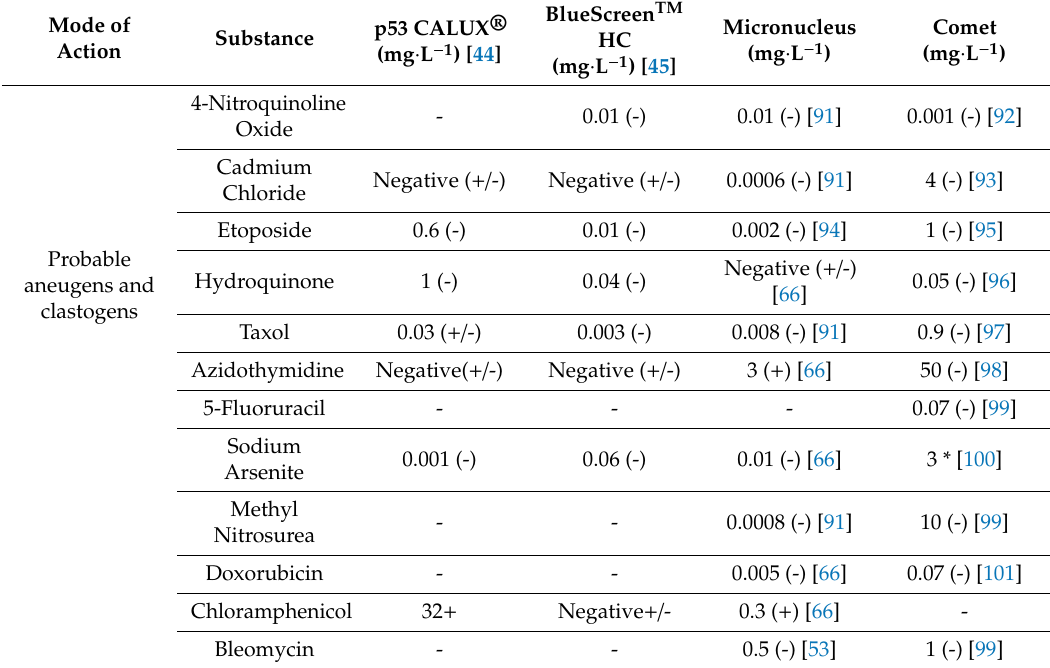
Table 3. Calculated limit of biological detection (cLOBD) for some aneugenic and clastogenic substances as found in a literature survey for the most commonly used mammalian in vitro assays, which cover these endpoints. A global concentration factor (GCF) of 10 was taken into account to normalize the